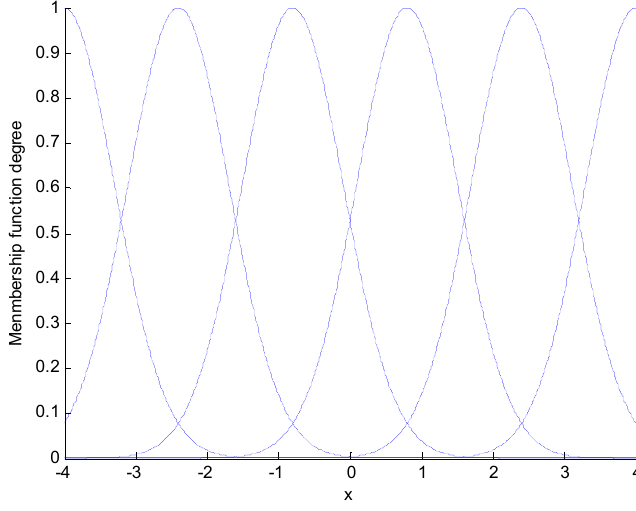
Figure 3. The member function degree of x .